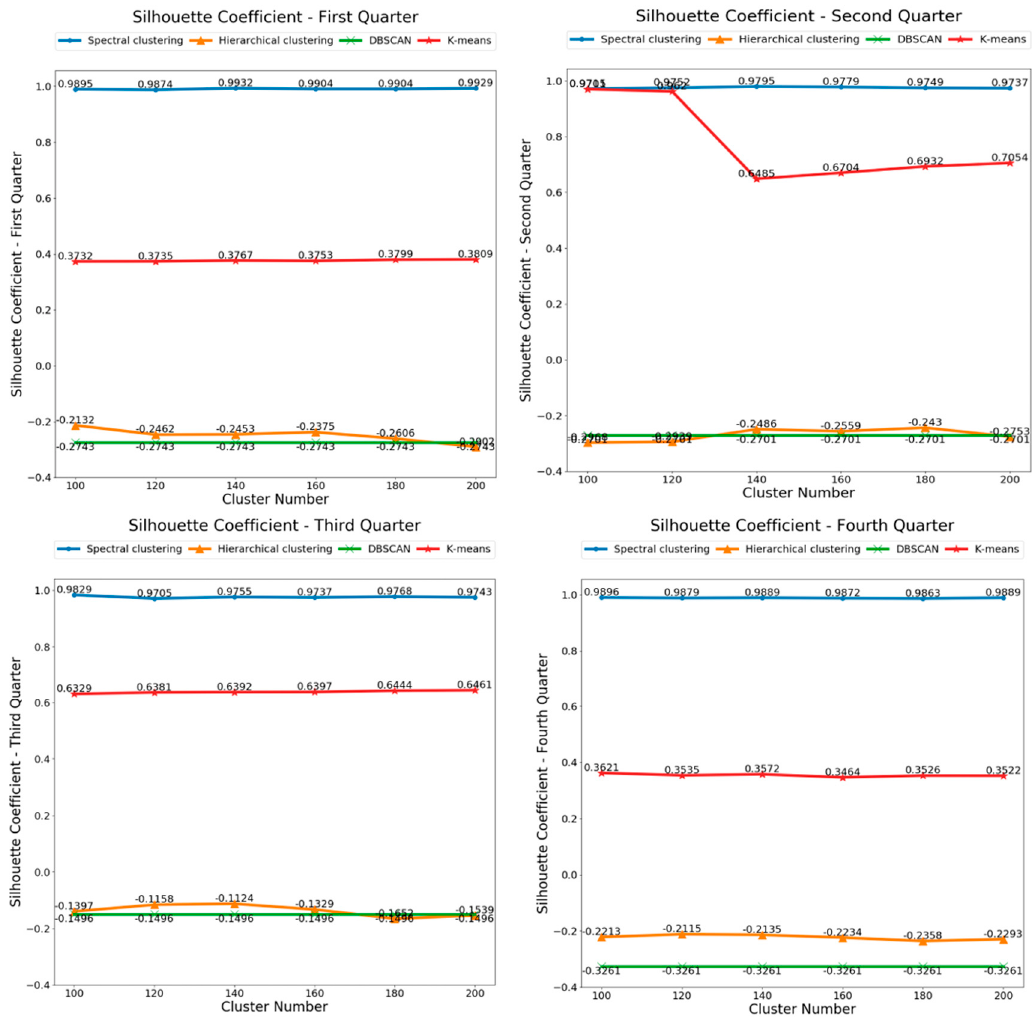
Figure 12. The Silhouette Coefficients of different clustering algorithm.